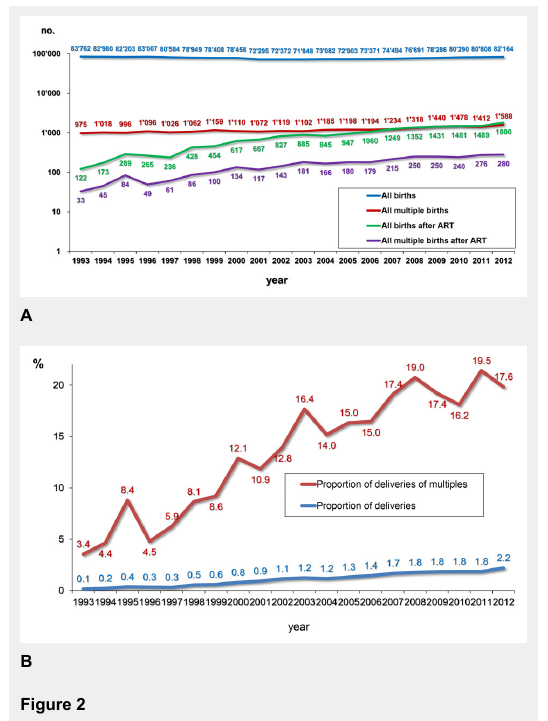
A By putting together the number of all deliveries and the overall number of multiple deliveries (given by the BfS) and the number of deliveries and multiple deliveries after ART (recorded by FIVNAT- CH), the number of births and multiple births generated by ART can be compared with the overall birth data in Switzerland. Since 1993 both the absolute number of births generated by ART and the absolute number of multiple deliveries, mostly of twins, have been rising continuously.